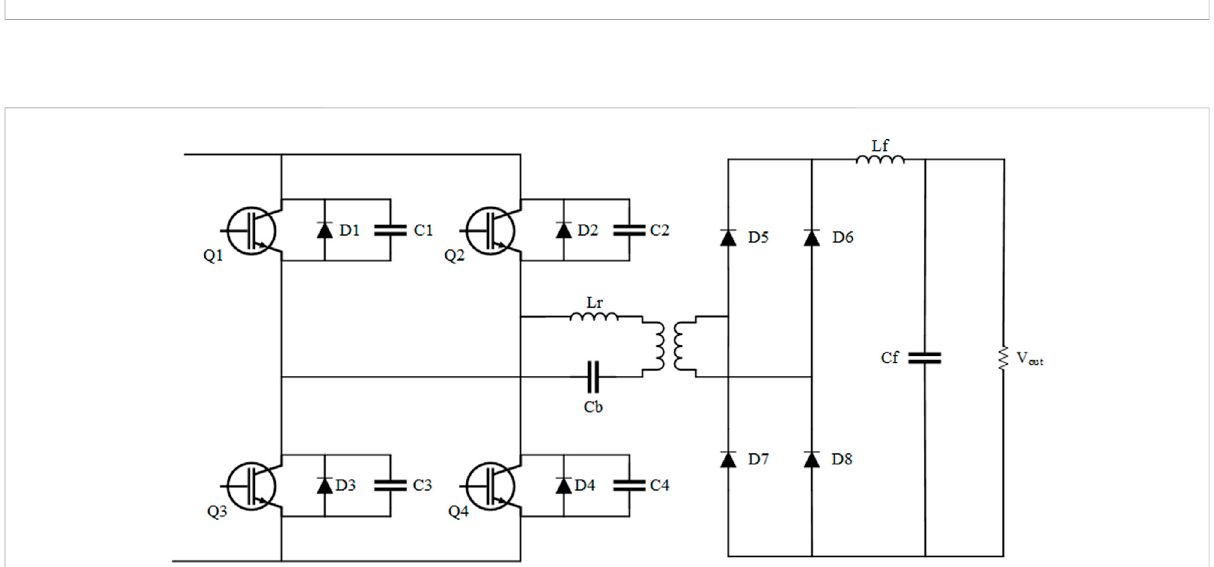
FIGURE 5 Topological structure of VIENNA recti fi er circuit of front-end circuit.